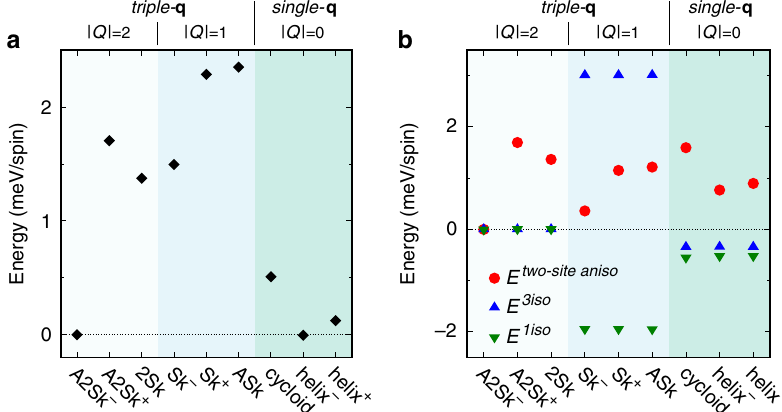
Fig. 4 Total internal energies of selected spin con fi gurations for NiI 2 . a Total internal energies of triple- q states with topological charge ∣ Q ∣ = 2 and ∣ Q ∣ = 1 and of selected single- q states. All energies, given with respect to the lowest-energy A2Sk state in units of meV/spin, have been calculated for NiI using a 24 × 24 supercell with periodic boundary conditions. The superscript ± denotes the chiral partners of the given spin texture, related by a re fl ection with respect to the xy plane (and consistent with the sign of the off-diagonal terms stabilizing the given spin con fi guration, as discussed in the text). The single- q spin con fi gurations have been generated by MC simulations arti fi cially tuning the two-site anisotropy term. b Contributions to the total internal energy E 1iso , E 3iso , and E two-site aniso due to isotropic and anisotropic exchange interactions parametrized by J 1iso , J 3iso and J two-site aniso , respectively, given with respect to the lowest-energy A2Sk state in units of